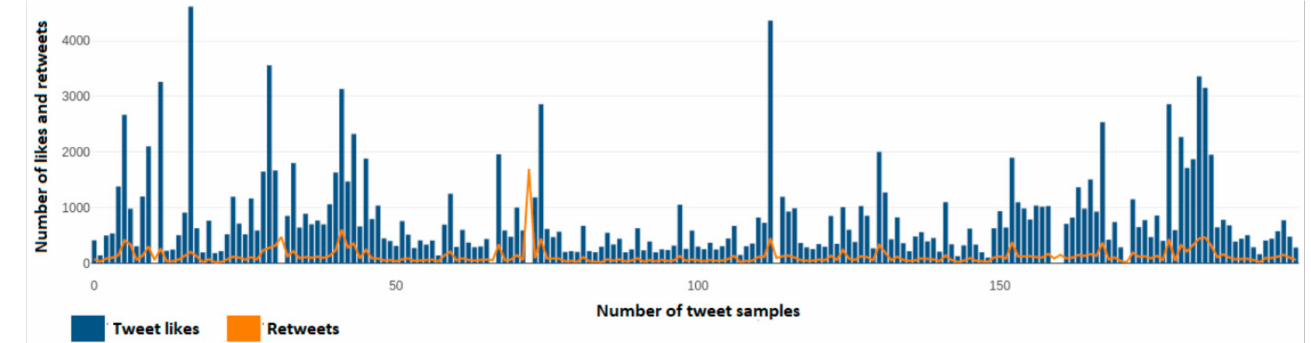
Figure 7. Number of likes and retweets per tweet for @kmitsotakis (200 tweet sample). Figure 8 depicts the number of user reactions, likes, and retweets of each tweet from a dynamic sample of 200 tweets taken from the Hellenic Prime Minister (@primeMinisterGR) account, which currently Kyriakos Mitsotakis administers. Axis y depicts the number of likes and retweets that a single tweet has, while the x axis depicts the number of each tweet over this 200-tweet sample.